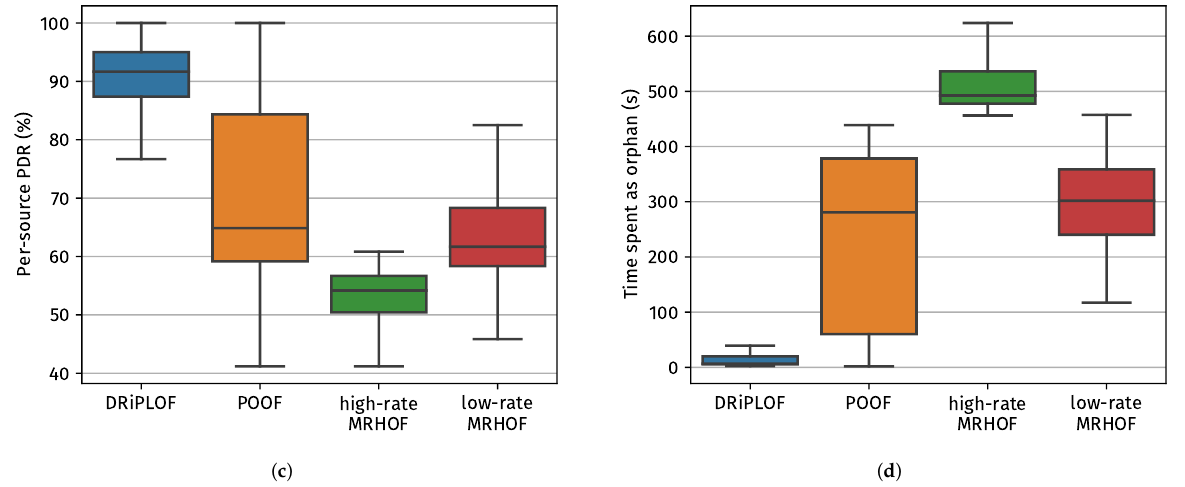
Figure 10. Simulation results for the conditions involving a jammer. ( a ) The end-to-end latency of upward data packets successfully received by the root. ( b ) The number of times a non-root node changed its preferred parent. ( c ) The ratio of data packets processed by the root to the number of T s expiration events. ( d ) The time spent (by a non-root node) detached from the